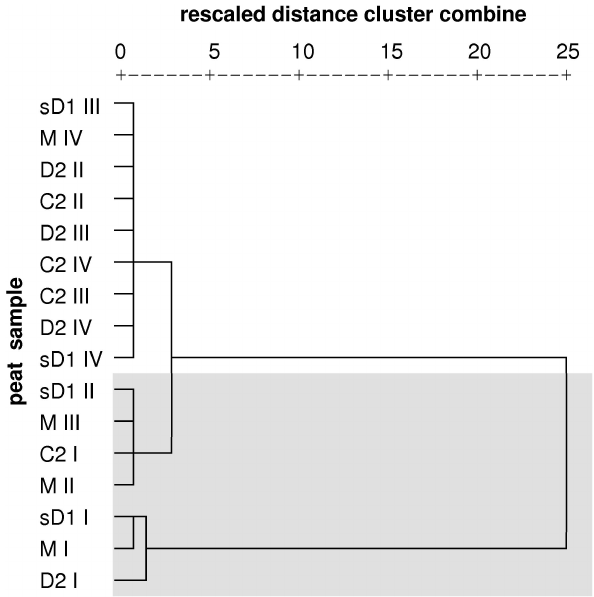
Fig. 1. Grouping of peat samples according to their CO 2 and CH 4 formation rates using hierarchical cluster analysis. The dendro- grams were carried out using the Ward method, based on Euclidean squared distances. Samples were obtained at different areas along a hydrological gradient from an acidic fen (from the middle to the south C2 → D2 → sD1 → M) over 4 depths (I: 0–10cm, II: 10–20cm, III: 20–30cm, IV: 30–40cm). Peat samples yielding CH 4 and CO 2 formation rates above 0.1 and 1.2µmolg (dry wt peat) − 1 d − 1 , re- spectively, are highlighted (grey